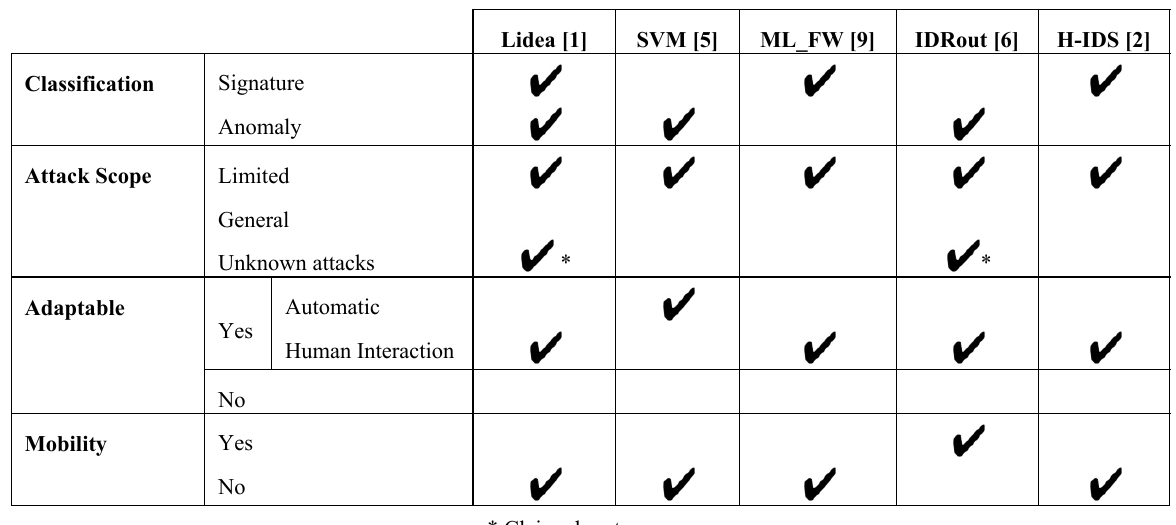
Table 1. Summary of the representative